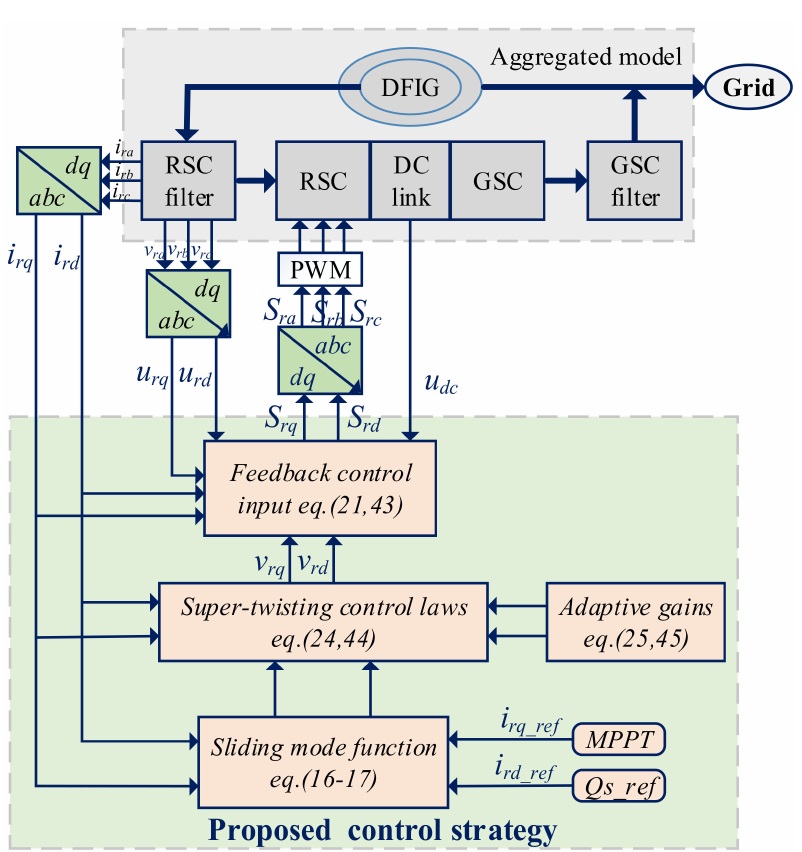
Figure 2. Schematic diagram of the proposed damping control